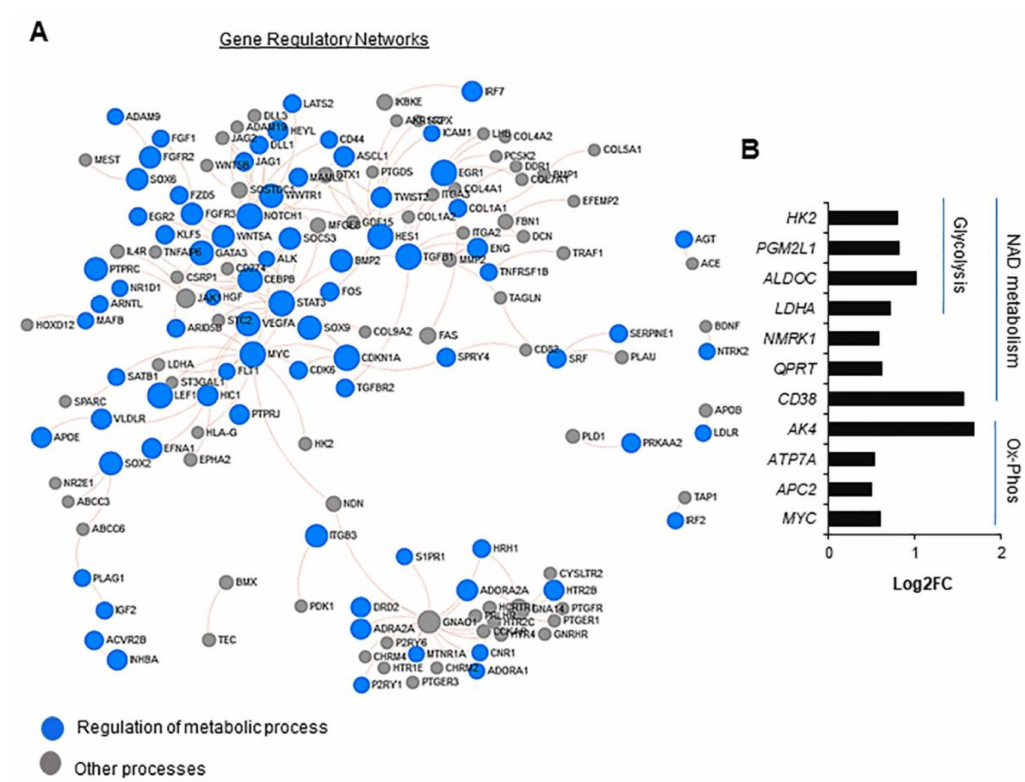
Figure 2. PA200 regulates the transcription of genes involved in cellular metabolism. ( A ) Examination of the minimal signaling network of genes transcriptionally affected by PA200 deficiency demonstrates the considerable representation of nodes, which are functionally linked to cellular metabolism. ( B ) PA200 silencing activated genes that contribute to NAD metabolism and mitochondria respiration. Differential gene expression is shown (shPA200 vs. shCTRL) derived from RNA-Seq data for NAD metabolic process (GO: 0019674), glycolytic process (GO: 0006096), and regulation of oxidative phosphorylation (GO: